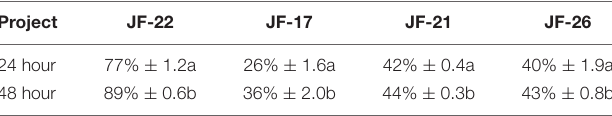
TABLE 1 | Ability of JF-22 to kill Meloidogyne incognita at the J2s stage. Project JF-22 JF-17 JF-21 JF-26